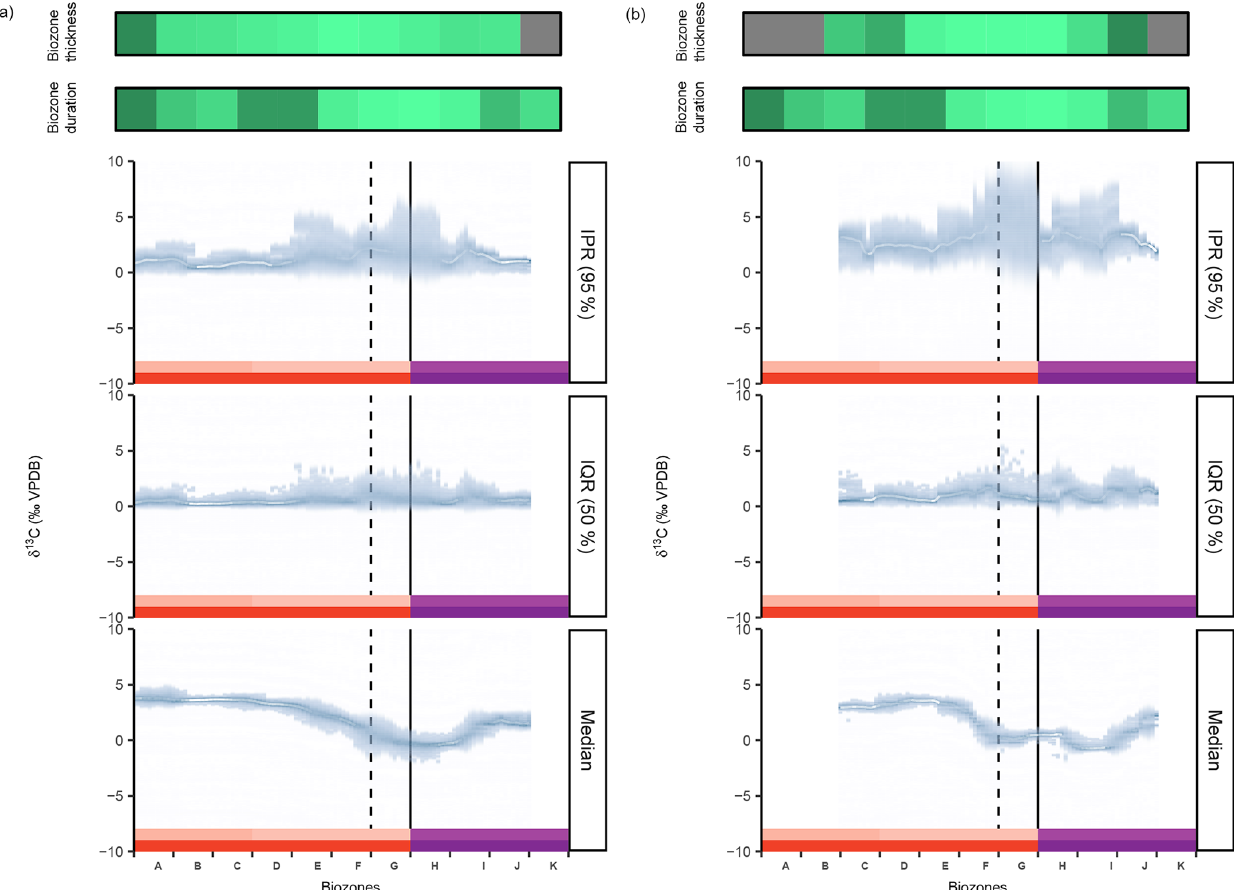
Figure 2. Visually weighted data plot for the Iranian (a) and South China (b) P–Tr (sub)localities (Sect. 3.1.3) depicting the median trend line, the IQR (50%) and the IPR (95%) δ 13 C value ranges. Trends with lowest fidelity are marked by a blurring of colours and less contrasted colours (based on the CI of multiple subsample routines). The dashed and the solid line represent the extinction horizon and P–Tr boundary, respectively. The saturation level of the green tiles in the upper two panels equals a more extended biozone thickness (0.12–32.00m) and longer duration (0.02–1.00My). Grey tiles represent intervals with no available biostratigraphic data. See Fig. 1 for colour legend of the stratigraphic